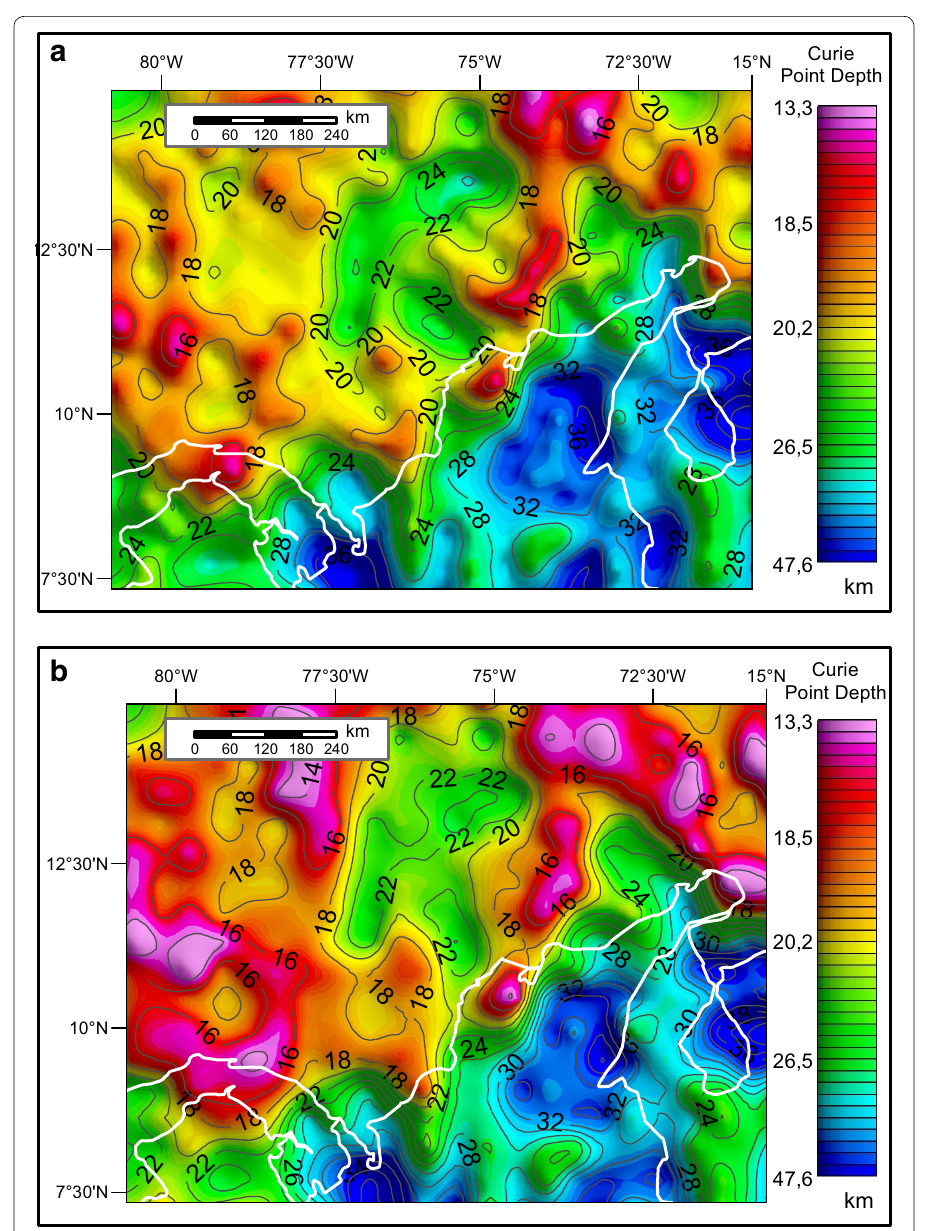
Fig. 4 Curie point depth maps. a Based on the Fractal method. b Based on the Centroid method. White line represents the country limit. Maximum and minimum CPD are 47 and 13 km,